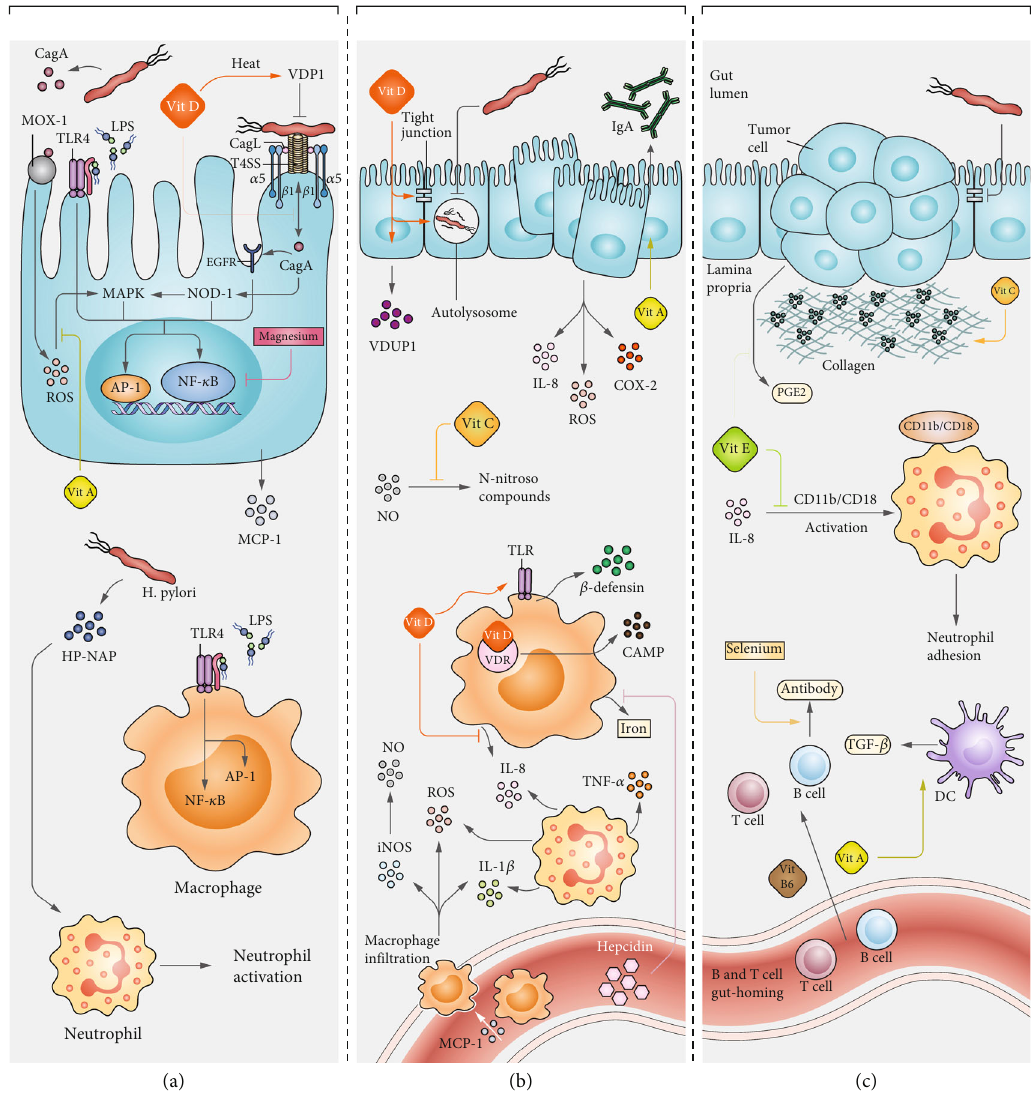
Figure 1: The e ff ect of micronutrients on H. pylori pathogenesis. (a) H. pylori can invade epithelial cells and interact with epidermal growth factor receptor (EGFR), toll-like receptor 4 (TLR4), and mitogen oxidase-1 (Mox1), thereby stimulating the activation of transcriptional factors and the production of reactive oxygen species (ROS). H. pylori neutrophil-activating protein (HP-NAP) and LPS lead to neutrophil activation and promotion of macrophage in fl ammatory responses, respectively. However, vitamin D and A interfere